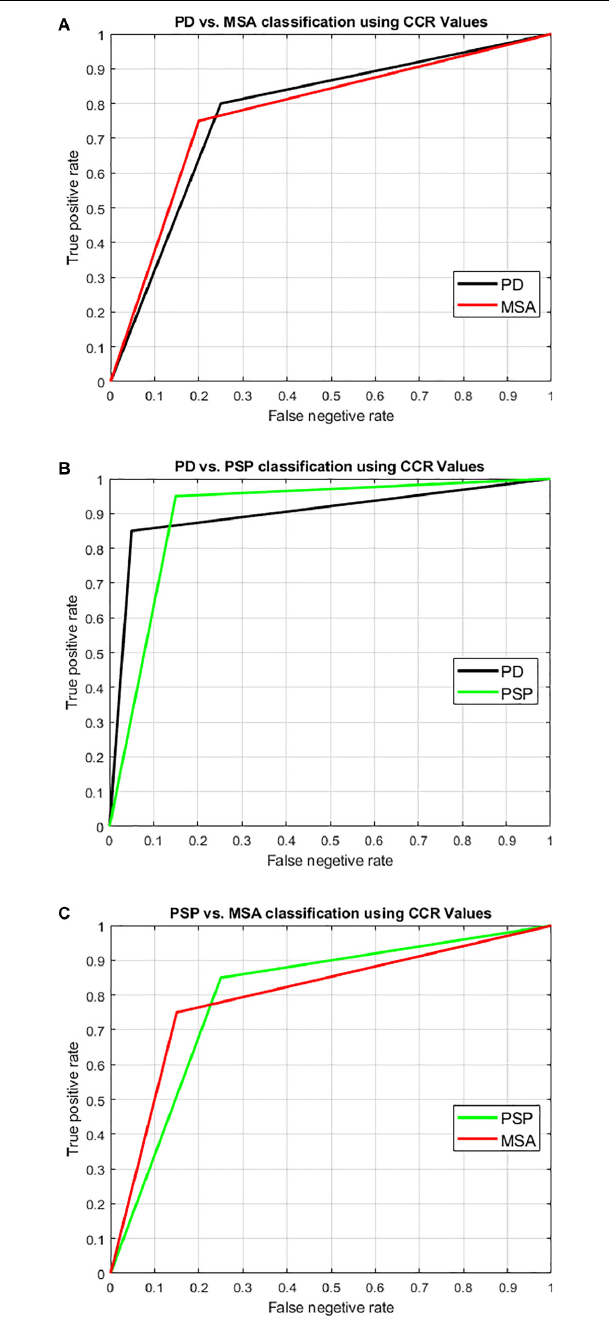
FIGURE 7 | Illustration of result of differential diagnosis using Receiver operator characteristics (ROC) curve. SVM with leave-one-out two-class classification was performed to classify the disease groups to check the potential of our technique to perform differential diagnosis. The two-class classification scenarios were: (A) PD-NC Vs. MSA, (B) PD-NC Vs. PSP, and (C) PSP Vs. MSA. The ROC curve pertaining to the classification into each group is shown here with the obtained result as tabulated in Table 6 . The area under the curve (AUC) is obtained as 0.825, 0.90, and 0.8 relating to both groups in each of the classification scenarios respectively. Comparing all disease groups, the highest accuracy with AUC over 0.9 was obtained when classifying typical PD (PD-NC) with respect to